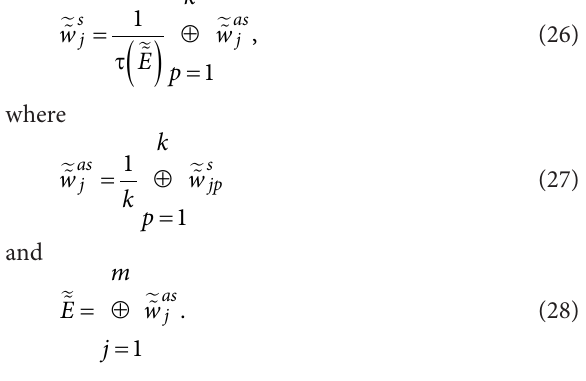
Table 1. Linguistic variables and the corresponding trapezoidal IT2FSs Linguistic variable Interval type-2 fuzzy sets